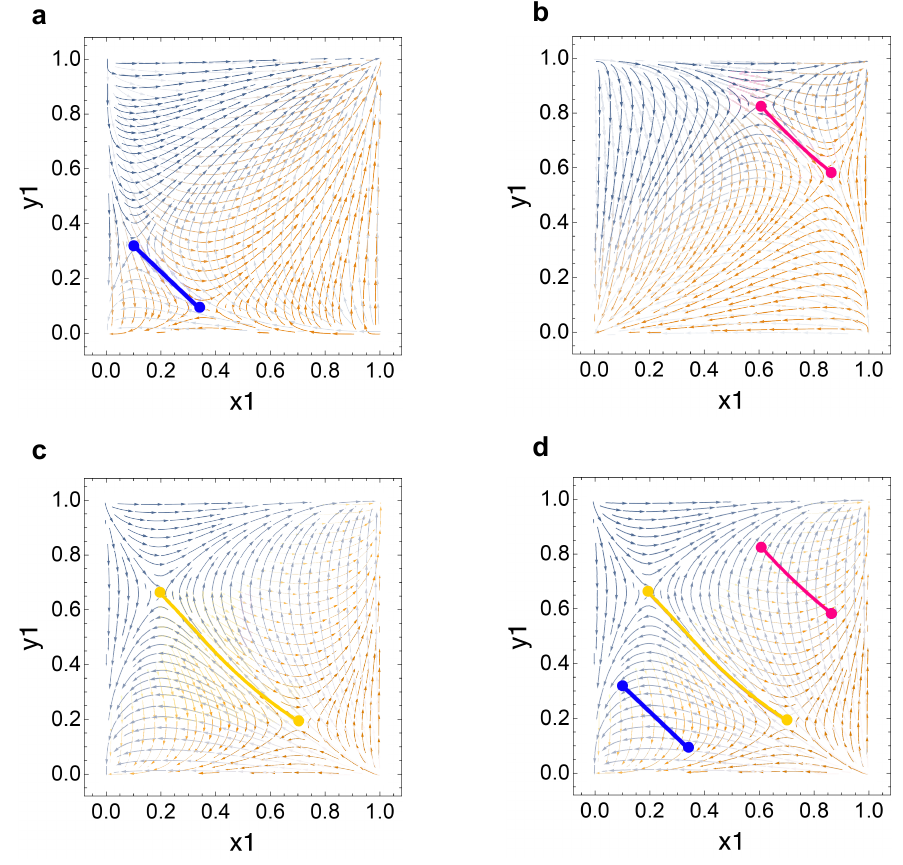
Figure 13. Attractor arc drift transformations. ( a ) Arc transformation with high gig payoff matrix operation, see Figure 11; theoretical GameState pair, see Figure 1; and δ a q = δ d q = 10. ( b ) Arc transformation with high employee payoff matrix operation, see Figure 12; theoretical GameState pair, see Figure 1; and δ a q = δ d q = 10. ( c ) Reference attractor arc with theoretical GameState pair, see Figure 1. ( d ) Composite diagram with arcs ( a – c